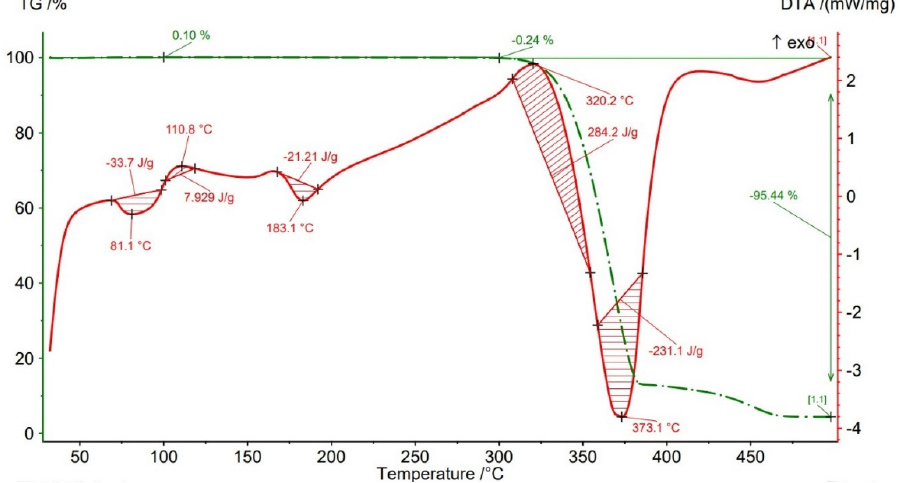
Figure 12. Thermogravimetric analysis results for Filaticum PLA − GF filament.